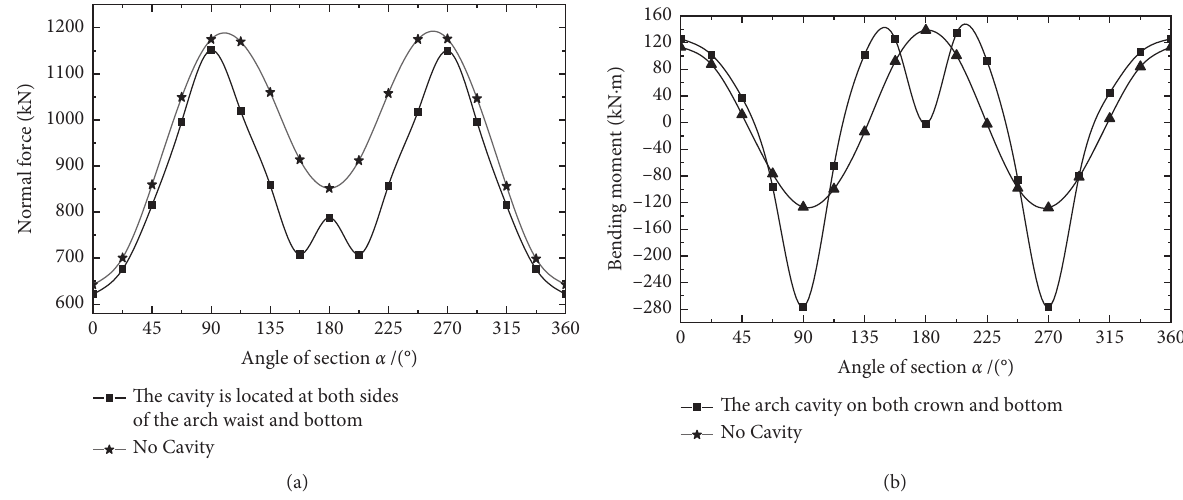
Figure 33: Internal force diagram of the segment under the condition of the cavity at both sides of the arch waist and arch bottom. (a) Segment axial force. (b) Segment bending moment.